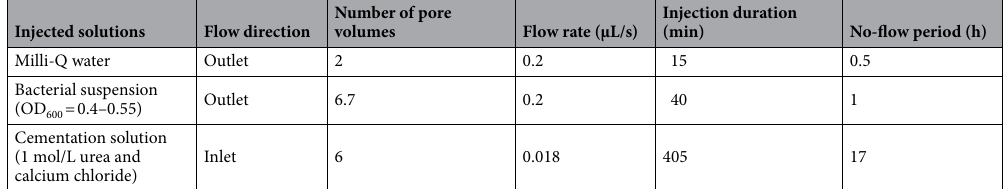
Table 1. The MICP injection strategy was applied in triplicate to the homogeneous and heterogeneous microfluidic